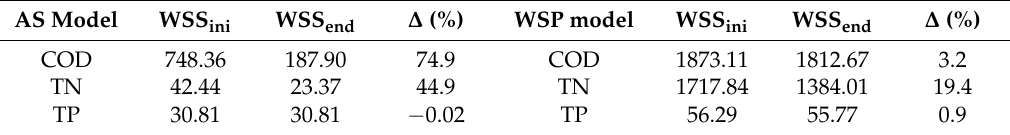
Table 5. Weighted sum of squares (WSS) for initial and end values (after parameter estimation). AS